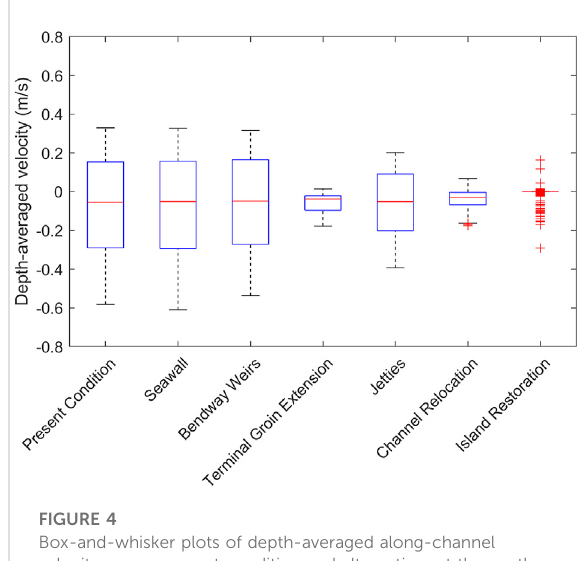
FIGURE 4 Box-and-whisker plots of depth-averaged along-channel velocity versus present condition and alternatives at the south fl ood channel. Negative velocities indicate ebb fl ows, while positivevelocitiesindicate fl ood fl ows.Thehorizontalredline indicatesthemedianvelocity.Theverticallengthoftheblueboxes indicates the 25th and 75th percentiles of velocity. The black whiskers extend to the maximum and minimum velocities, excluding outliers, which are represented with red plus